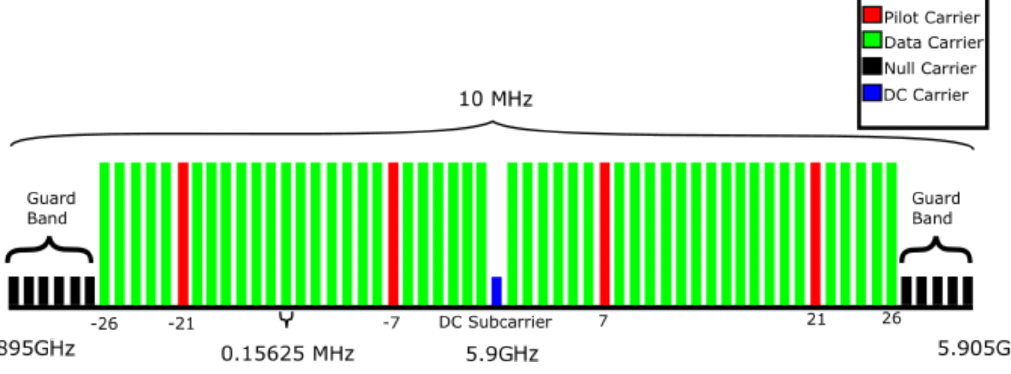
Figure 3. IEEE 802.11p subcarrier distribution.